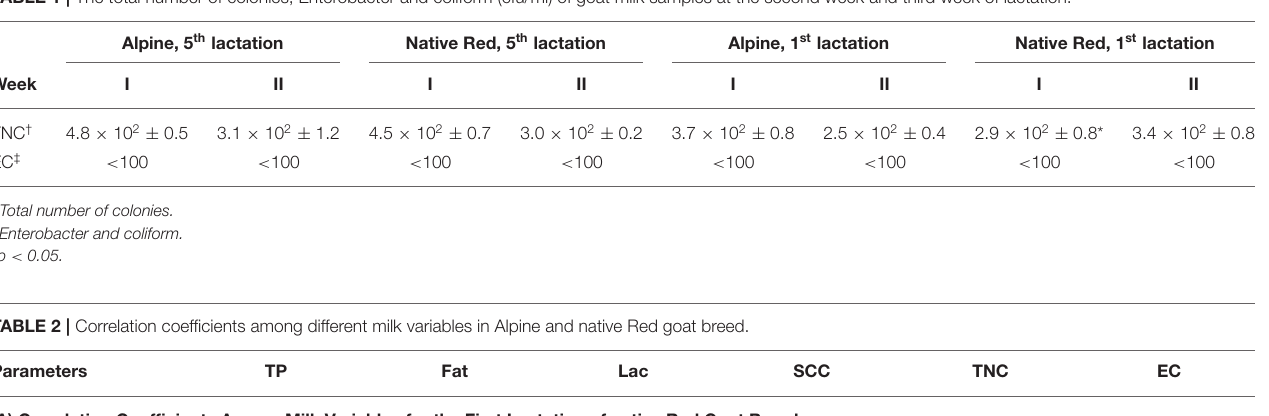
TABLE 1 | The total number of colonies, Enterobacter and coliform (cfu/ml) of goat milk samples at the second week and third week of lactation.